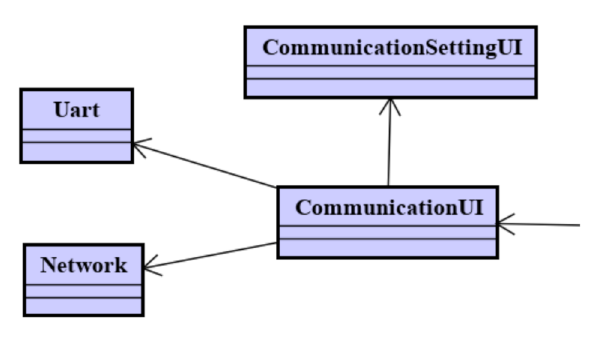
Figure 5. Communication-system architecture at the design